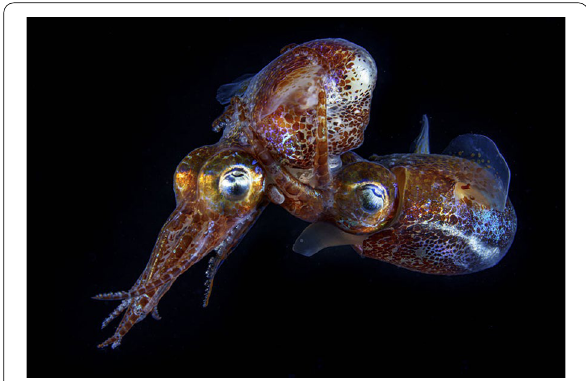
Fig. 6 Mating between Eumandya cf. parva (Gustavo Sanchez det.) in the field (female to the left). Male’s arms I are inserted in the female’s mantle cavity, as shown by the mantle bulging; arms II embrace the female’s mantle and extend dorsally above the female’s fins; arms III embrace the female’s neck and join with each other slightly above the female’s head; the proximal part of arms IV are attached to the female’s head, the distal part is free. Okinawa (Japan), off Cape Kyan, time: 10 pm (photo © Kenji Imai,